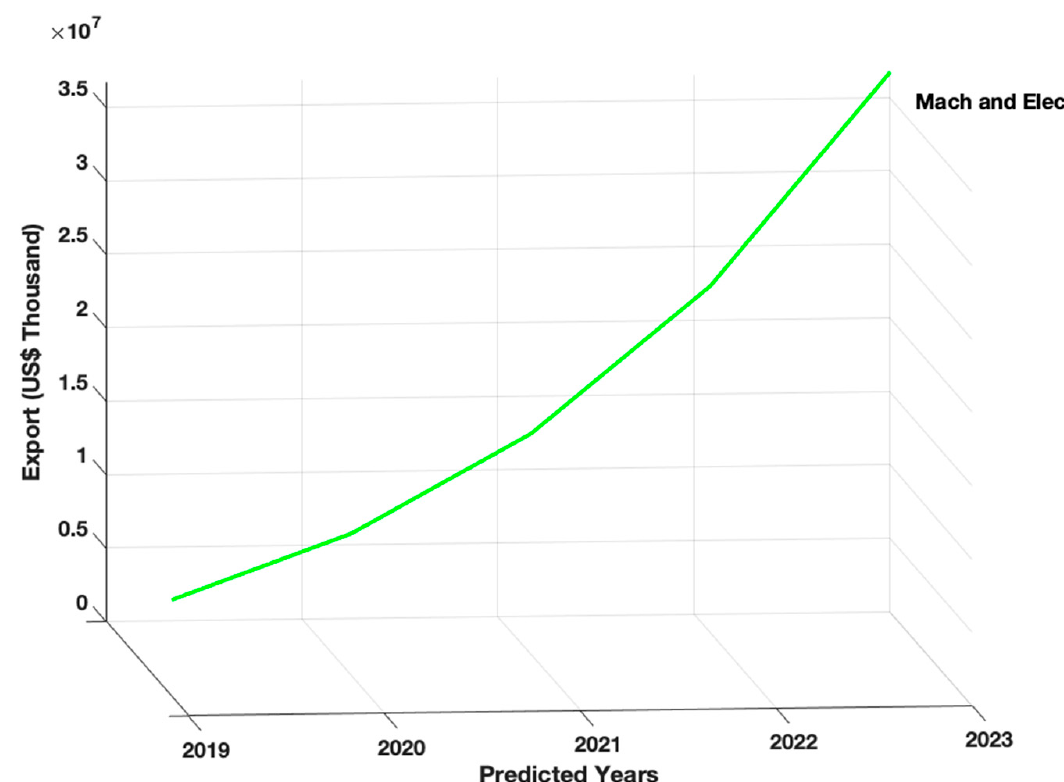
Figure 6. Prediction for machinery and electrical machinery based on our model.